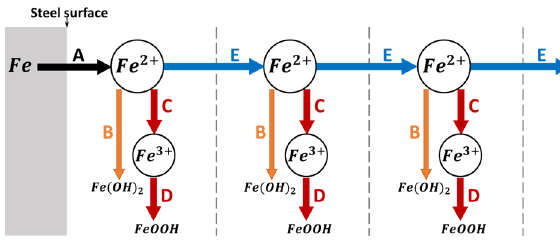
Figure 2. Schematic representation of the model reaction path (steps A to E) from steel corrosion to formation of solid corrosion products in the (water filled) pore system of concrete. The dashed vertical lines represent imaginary vertical slices of the concrete, illustrating the chosen finite element model approach in this work, to predict the concentrations of the different species as a function of both time and distance from the steel